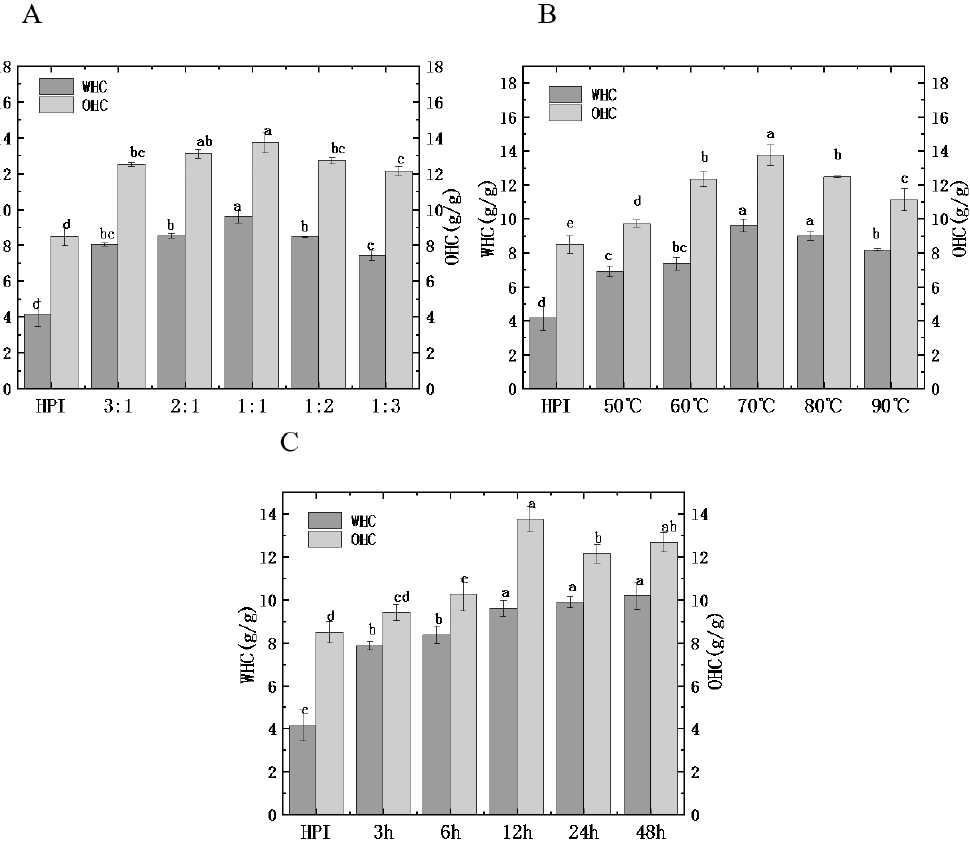
Figure 7. Effect of hemp protein isolate (HPI) ratios to pullulan ( A ), incubation temperature ( B ), and incubation time ( C ) on the water and oil absorption capacity (WAC/OAC) of glycosylated HPI. Different superscript letters represent a significant difference ( p < 0.05). WHC: water holding capacity. OHC: oil holding capacity.